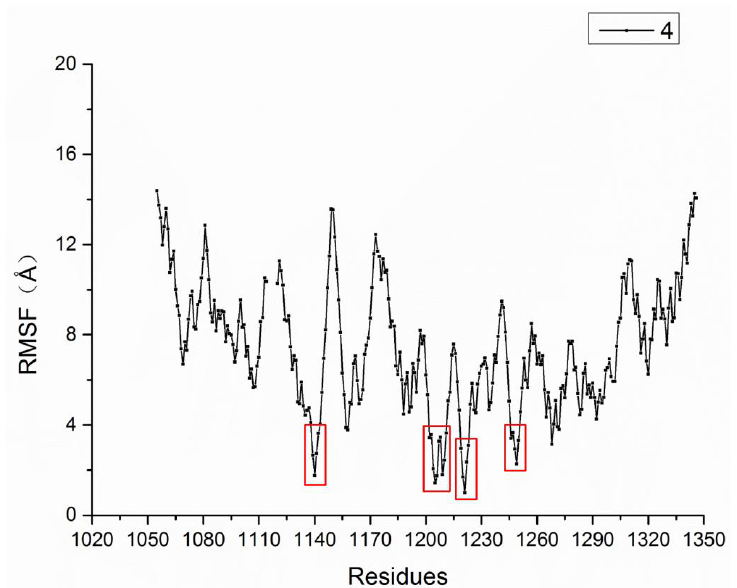
Figure 11. Root mean square fluctuation (RMSF) of the system.